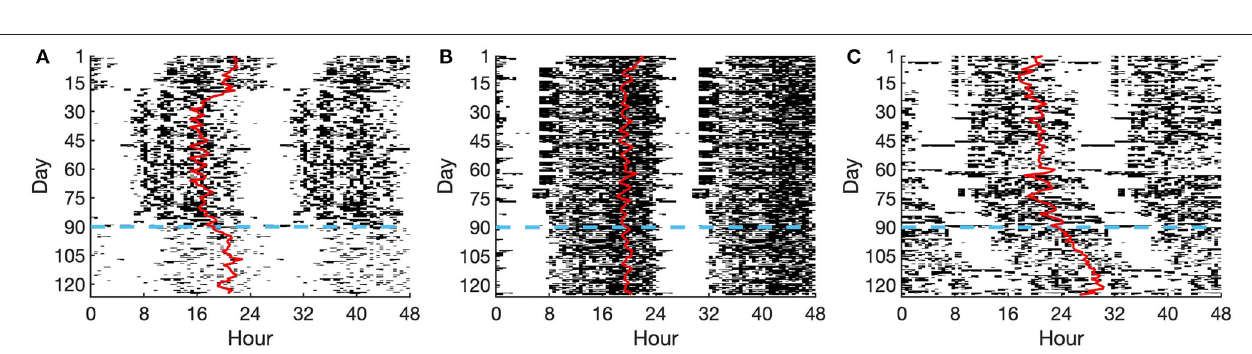
FIGURE 2 | Actograms of selected individuals. (A) College student, (B) Parent, (C) Shift worker. Activity is shown as dark bars, with thicker bars corresponding to more steps taken at that time. The red line represents the DLMO phase prediction from the limit-cycle oscillator model, and the horizontal dashed blue line denotes the date of social distancing